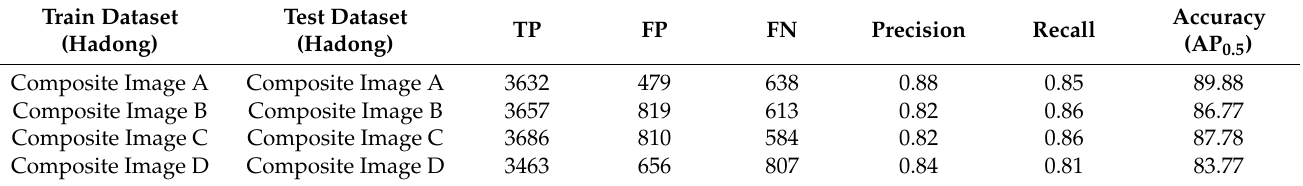
Table 4. Detection accuracy results for individual composite image dataset A~D with tinyYOLOv4 [41].